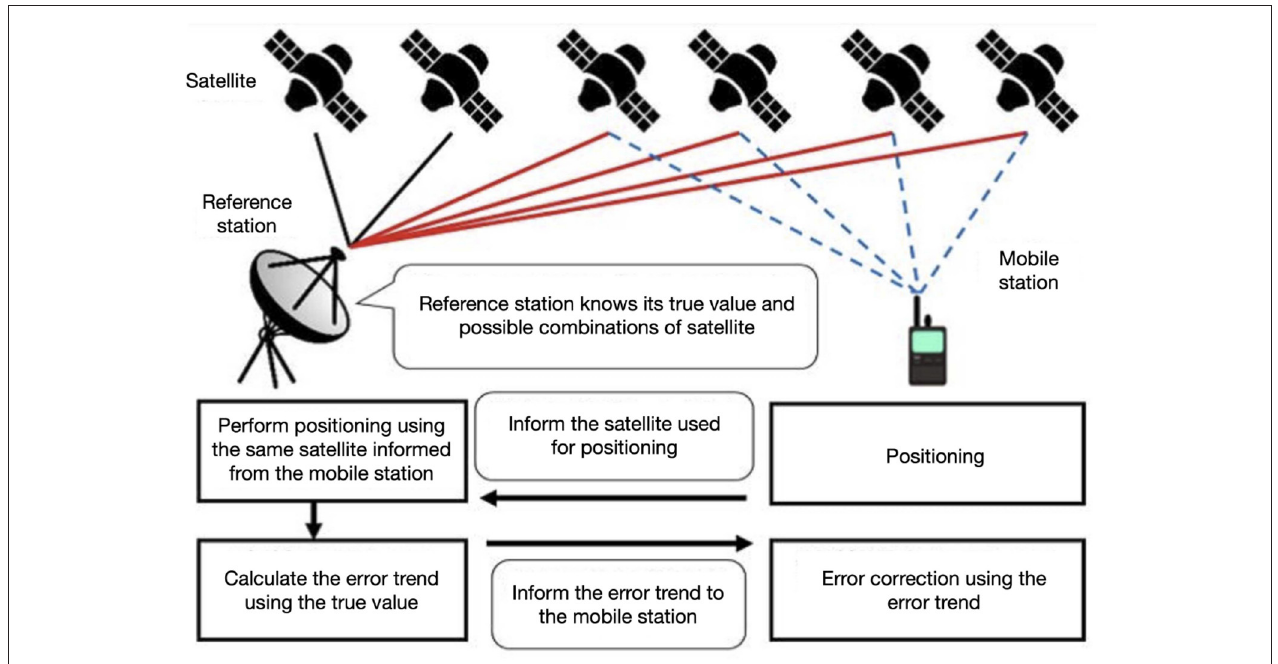
FIGURE 3 | System model of using a common temporal